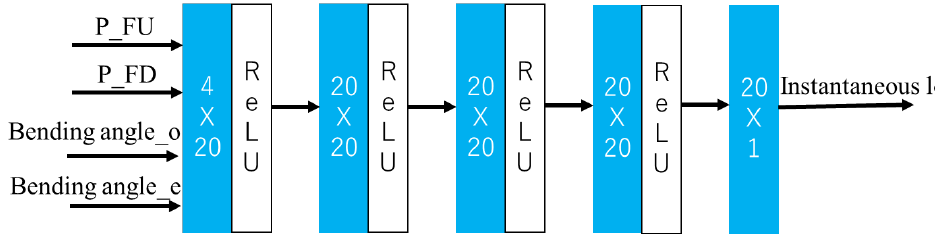
Figure 2. The architecture of the active load-sensing scheme.